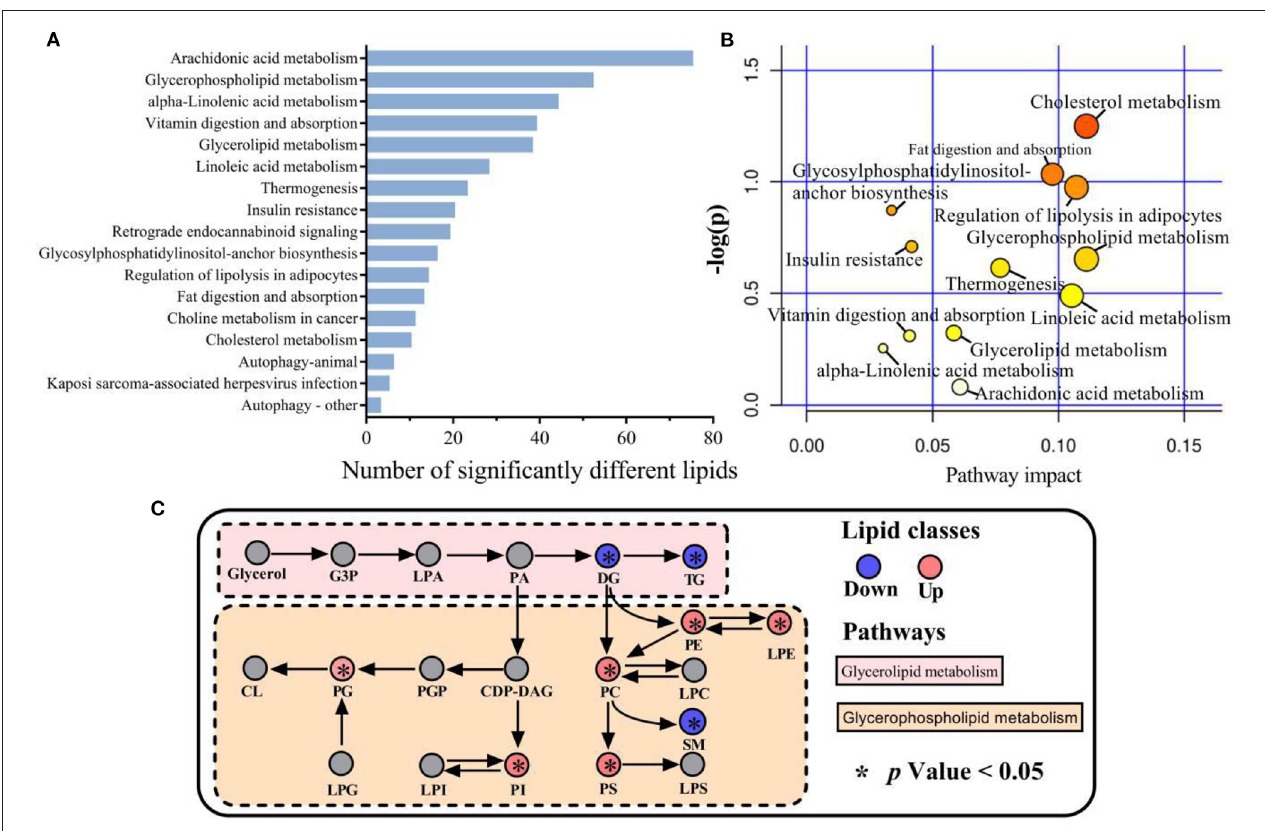
FIGURE 5 | Metabolic pathways involved in different lipid species of LDM and VAT. (A) Kyoto Encyclopedia of Genes and Genomes (KEGG) enrichment pathways of significantly different lipids in LDM compared with VAT. (B) Map of significant metabolic pathways in LDM compared with VAT. (C) Enrichment of significantly different lipids in glycerolipid and glycerophospholipid metabolism in LDM compared with